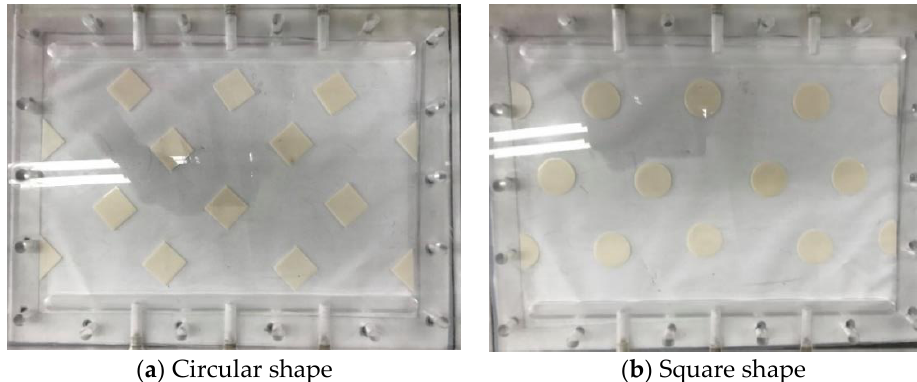
Figure 4. Top view of two kinds of turbulence promoters.